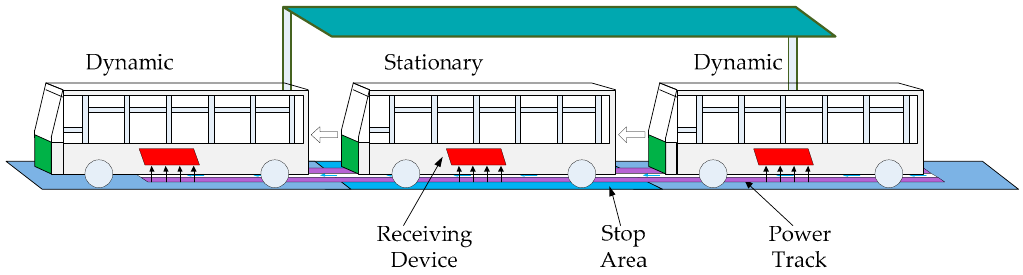
Figure 4. The schematic diagram of the opportunistic hybrid wireless charging scenario for electric bus.